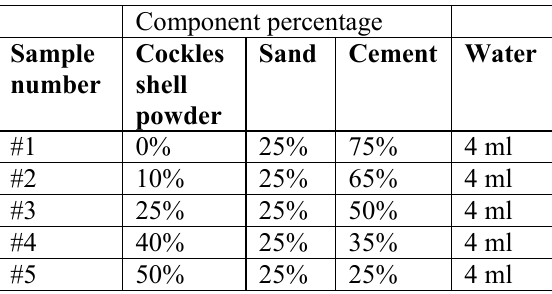
Fig. 2: Powder of cockles shells obtained by ball milling of crushed shells. Table 1: Ratios of components of prepared mortars.